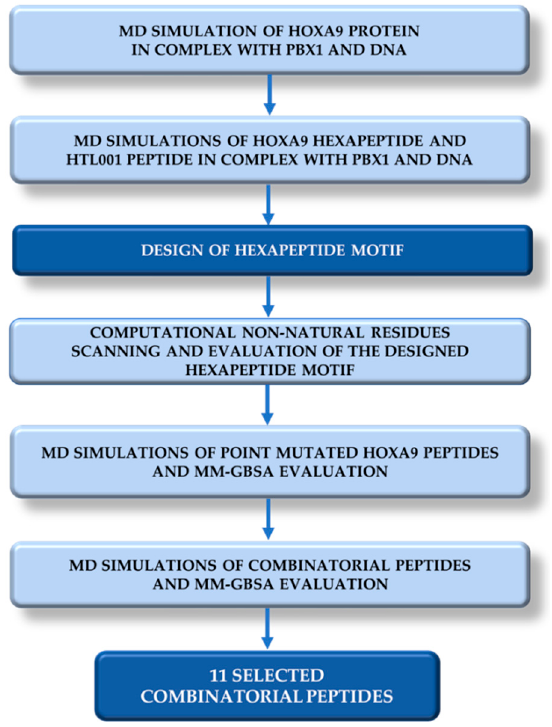
Figure 3. Overview of the computational workflow performed to identify the eleven combinatorial peptides potentially inhibiting HOX-PBX1 cooperative binding.